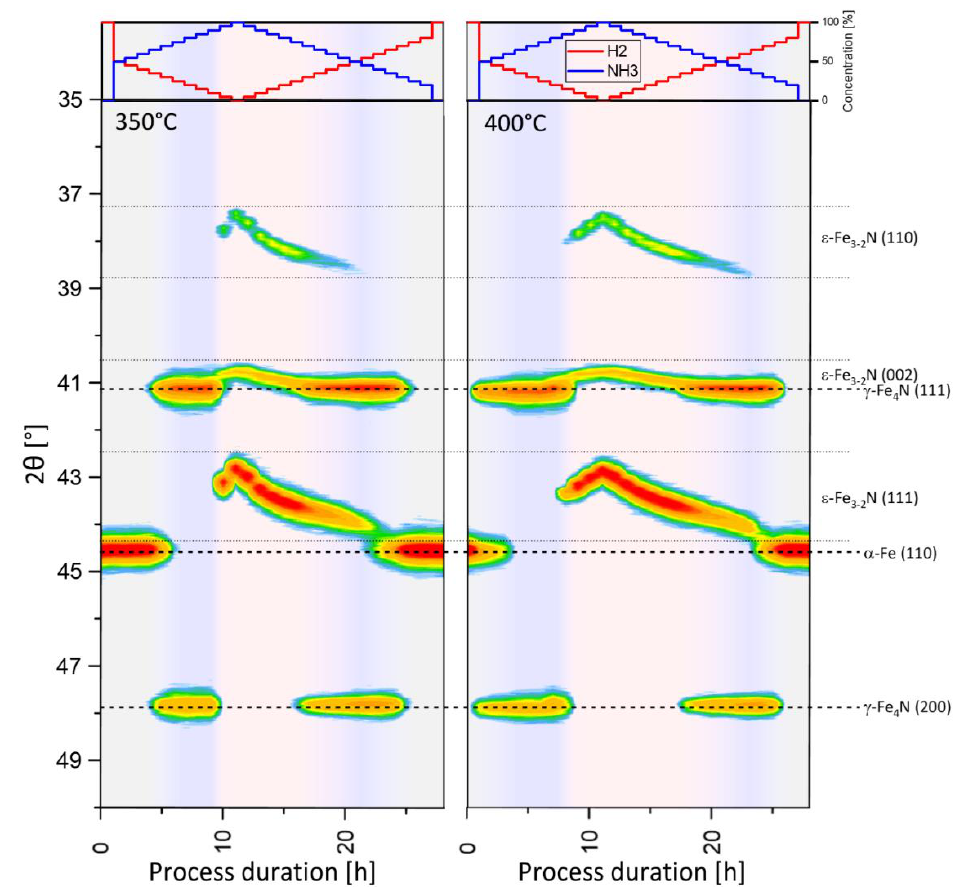
Figure 2. The course of the nitriding and denitriding processes performed at 350 °C and 400 °C observed by XRPD.